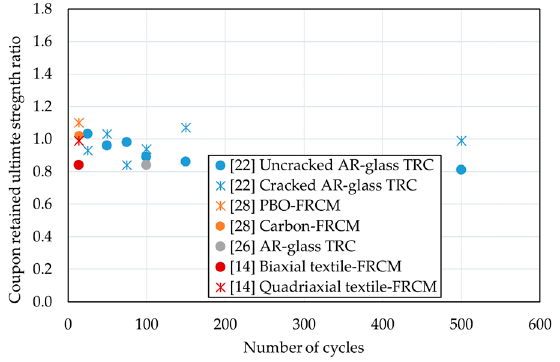
Figure 8. E ff ect of freeze–thaw cycles on the retained ultimate strength ratio of composite Figure 8. Effect of freeze–thaw cycles on the retained ultimate strength ratio of composite coupons.